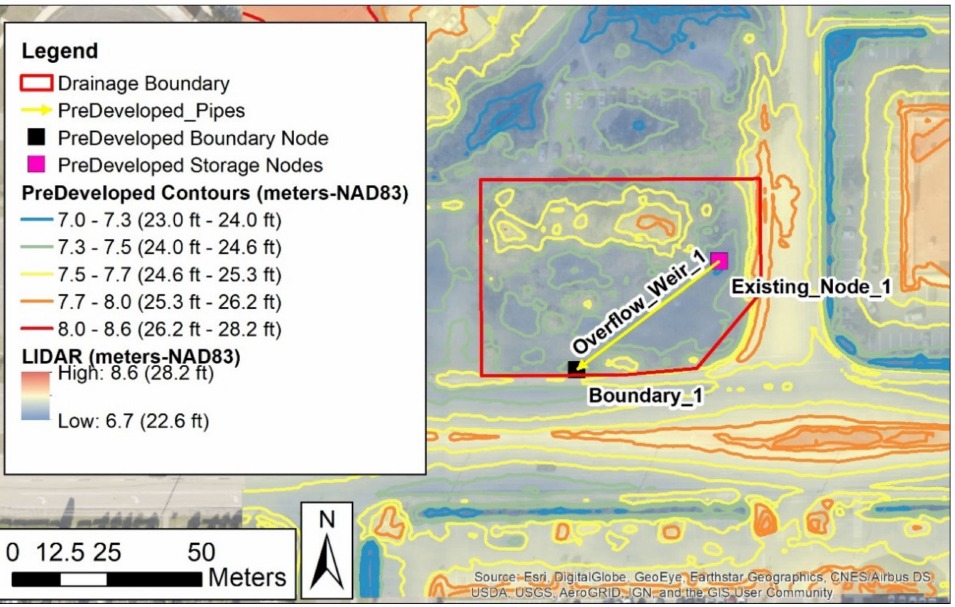
Figure 5. Predevelopment storage node, boundary node, and hydraulic connections (links).